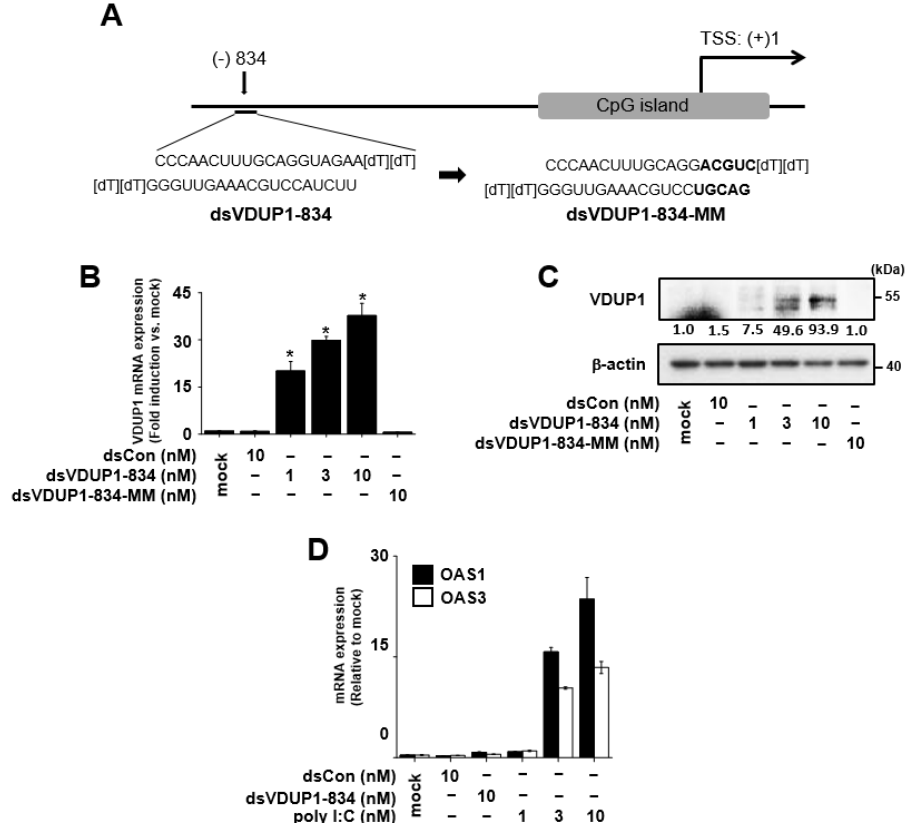
Figure 1. dsVDUP1-834 transfection induces VDUP1 expression in a dose-dependent manner in A549 cells. ( A ) Schematic representation of VDUP1 promoter showing target site and sequences of saRNAs. A549 cells were transfected with dsCon or indicated concentrations of saRNAs for 96 h. ( B ) The mRNA expression of VDUP1 was determined by qRT-PCR. ( C ) The protein expression of VDUP1 was assessed by Western immunoblot analysis. Normalized relative intensities are shown below the bands. ( D ) OAS1 and OAS3 mRNA expression was analyzed by qRT-PCR. Data are represented as mean ± S.D of triplicate determinations. * denotes that the response is significantly different from mock-treated group as determined by Dunnett’s t -test at p <